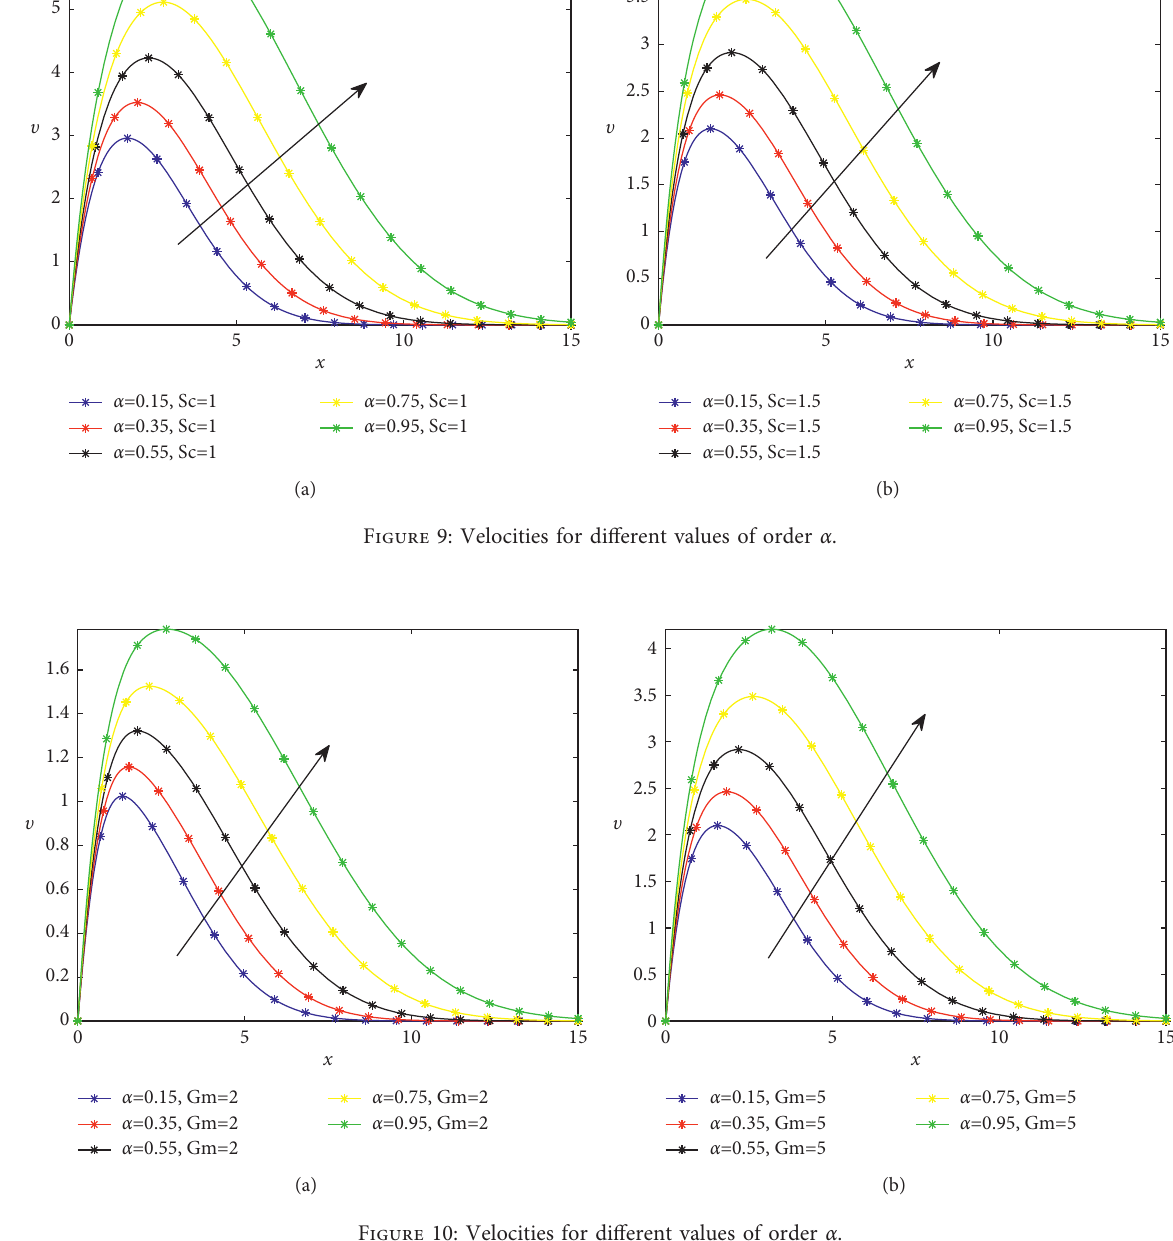
Figure 10: Velocities for different values of order α